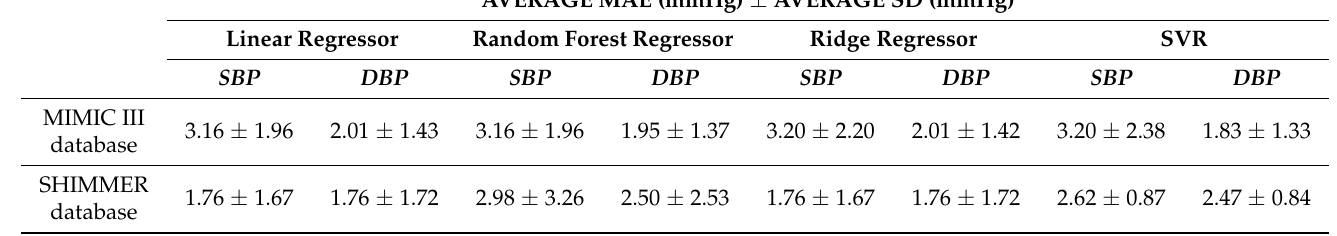
Table 1. Average MAE and average SD values in the testing phase with signals from MIMIC III and SHIMMER databases.